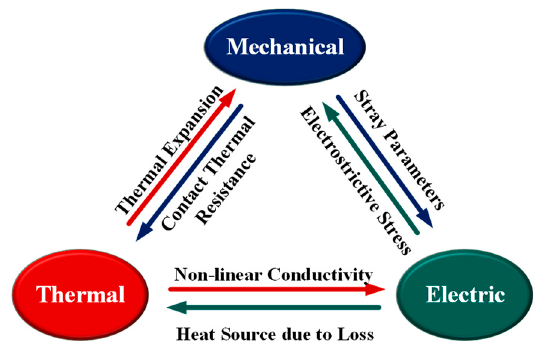
Figure 2. Coupling relationships among electrical, thermal, and mechanical factors in power module reliability.